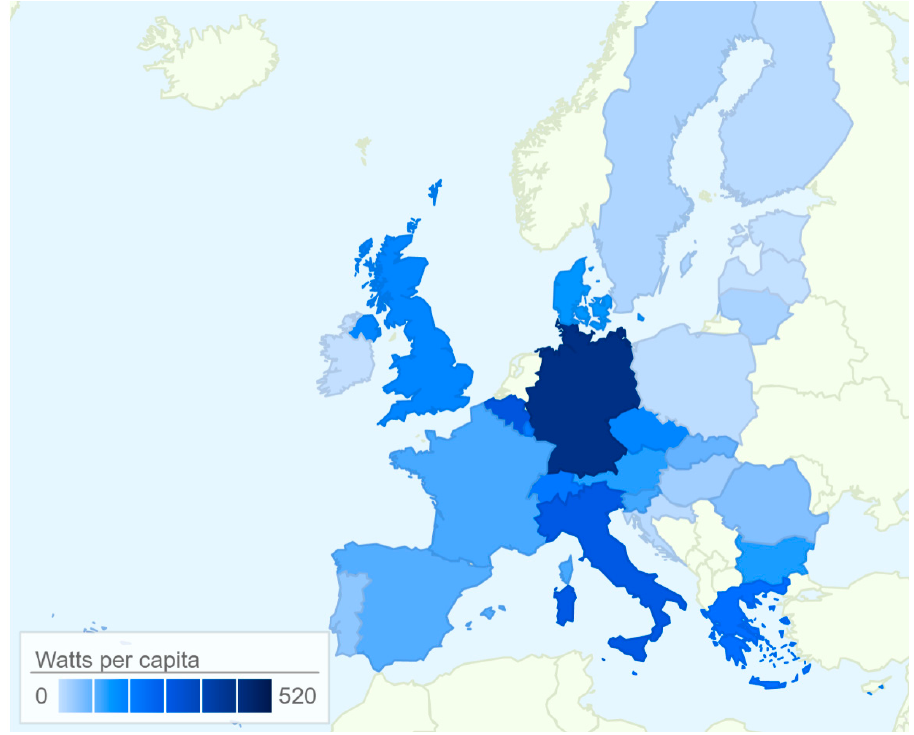
Figure 2. Penetration of solar PV systems in 2018, in Watts per Capita (own illustration).